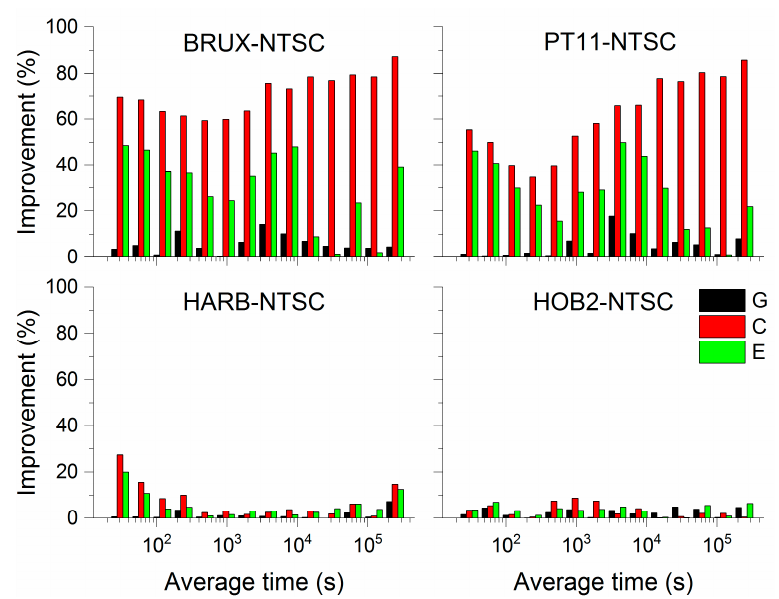
Figure 11. Percentage improvement in stability of multi-GNSS over the single-system using GBM products.